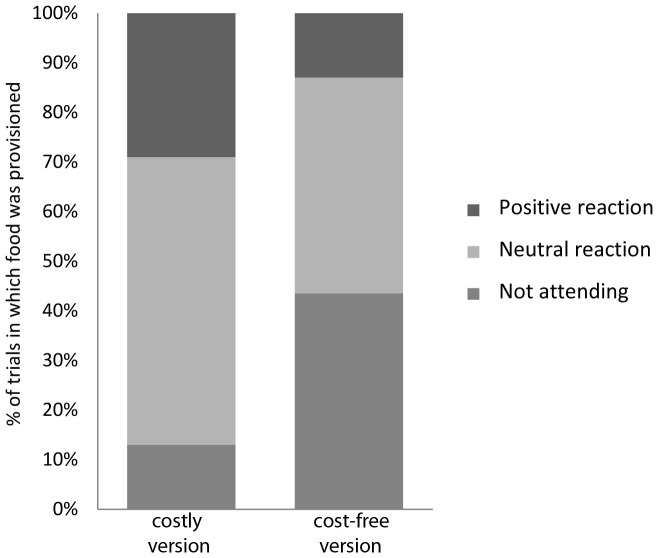
Reactions of the donor children to recipients taking the provisioned reward.The children could either not attend to the recipient at all, attend with a neutral emotional expression, or attend with a positive emotional expression.